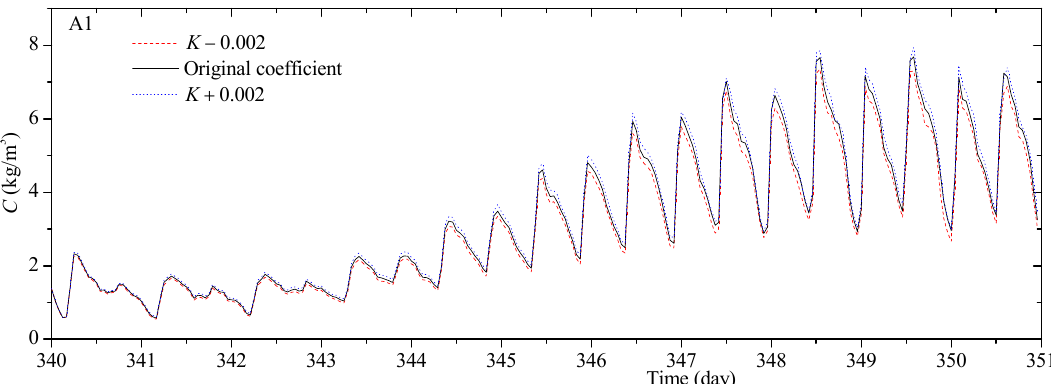
Figure 10. Comparisons of the histories of the simulated sediment concentration and field data (at Survey Point